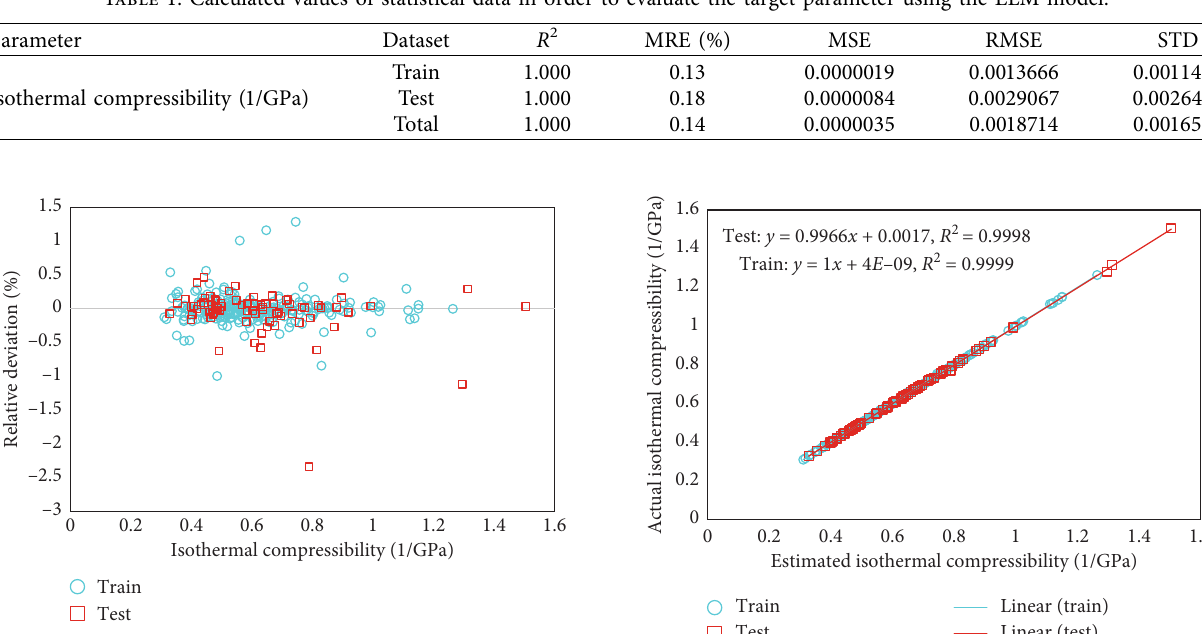
Figure 1: Relative deviation analysis performed on training and testing data.